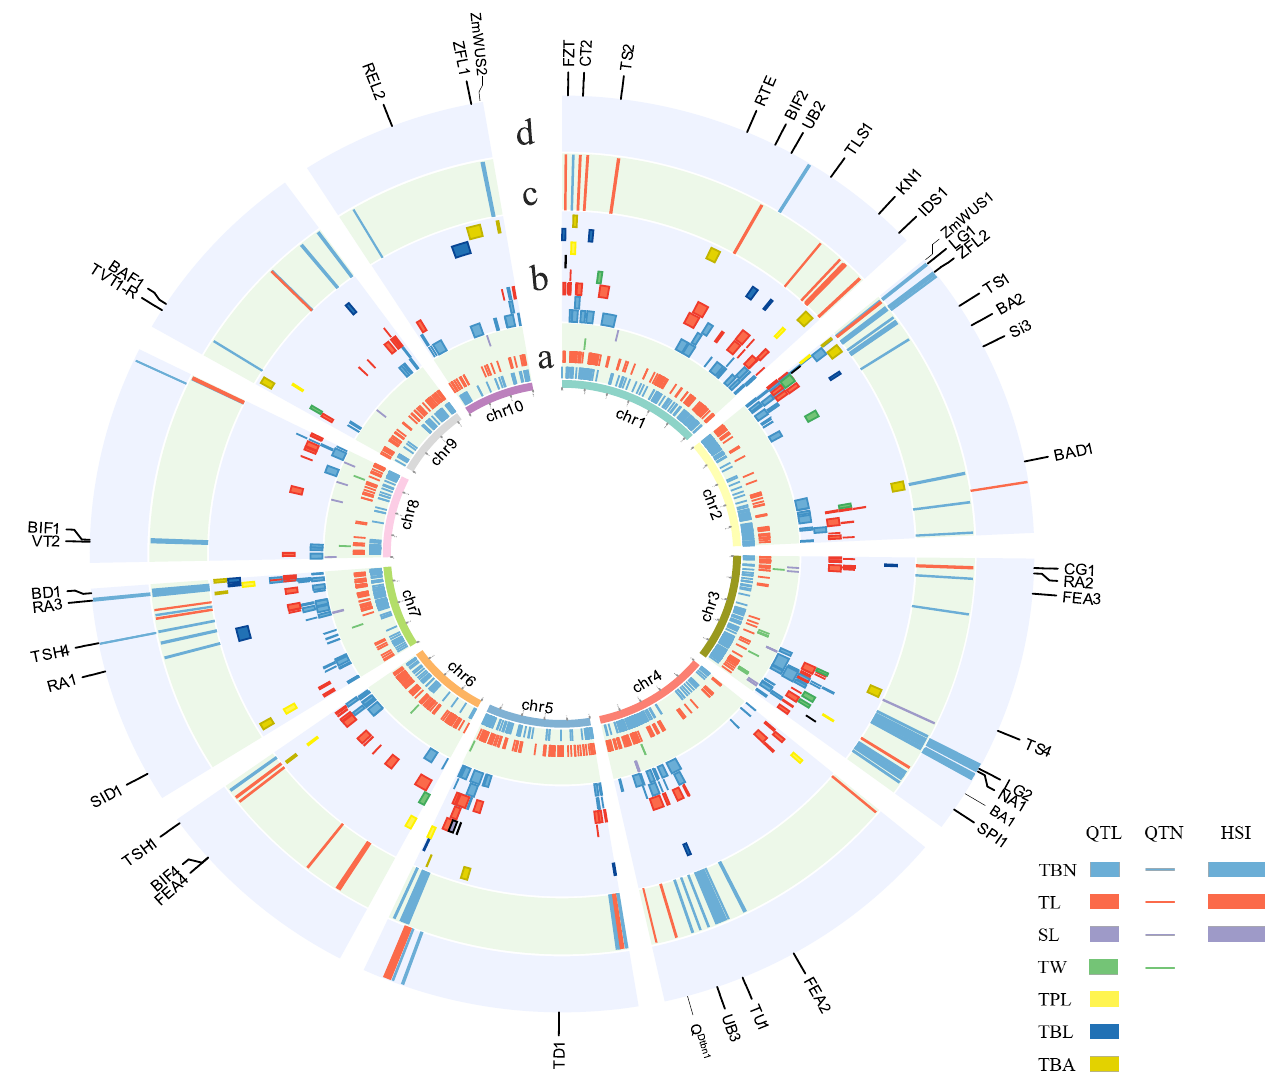
Figure 4. Consensus map of the genetic loci for tassel traits and distribution of the HSIs on maize chromosomes. The circle ( a ) represents the distribution of QTNs on chromosomes; circle ( b ) shows the distribution of QTLs on chromosomes; circle ( c , d ) represent the distribution of QTN-HSI and QTL-HSI on maize chromosomes, respectively. The physical position of known male inflorescence-related genes are shown on the outermost of the circles.